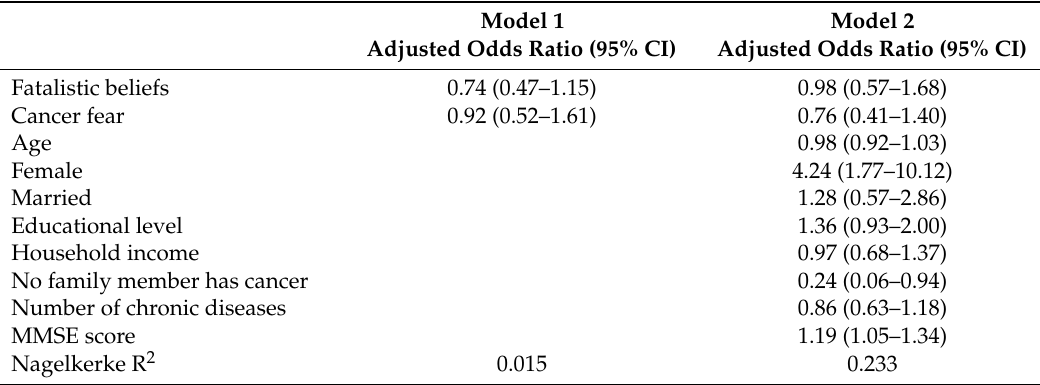
Table 3. Outcome of hierarchical regression analysis of cancer-related information scanning